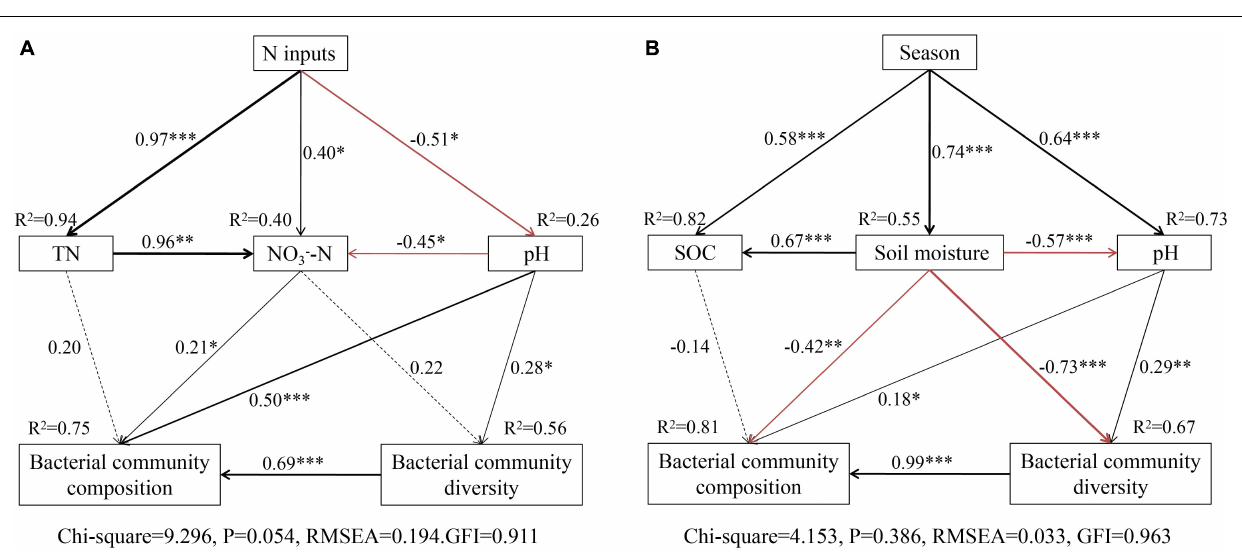
FIGURE 7 | Structure equation model (SEM) analysis of N addition (A) and seasonal changes (B) on soil bacterial communities via pathways of soil properties. Continuous and dashed arrows represent significant and non-significant relationships, respectively. Adjacent numbers that are labeled in the same direction as the arrow represent path coefficients and the width of the arrow is in proportion to the degree of path coefficients. Black and red arrows indicate positive and negative relationships, respectively. R 2 values indicate the proportion of variance explained by each variable. Significance levels are denoted with * P < 0.01, ** P < 0.01, and *** P < 0.001. The low chi-square (CMINDF), non-significant probability level ( P > 0.05), high goodness-of-fit index (GFI > 0.90), and low root-mean-square errors of approximation (RMSEA) listed below the SEMs indicate that our data matches the hypothetical